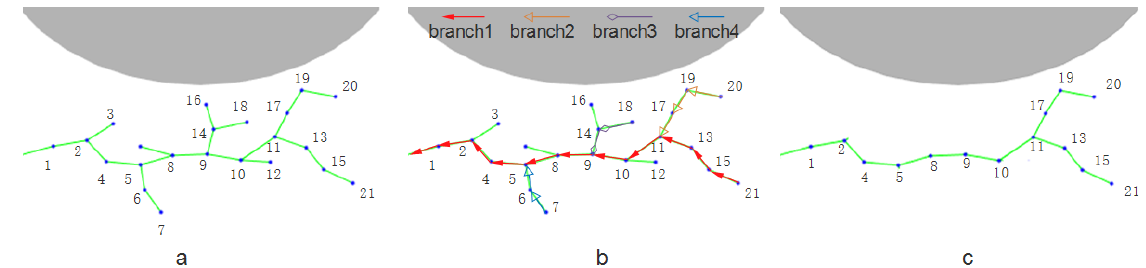
Figure 10. The withering of the exploring tree. (( a ) The tree before withering and the numbers are the order in which the nodes are generated, ( b ) branches of the tree, ( c ) remove branches with length less than len = 3).